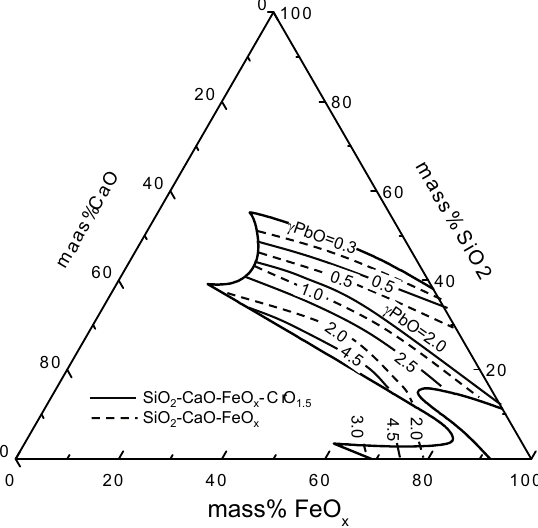
Figure 8. Contours of constant PbO activity coefficient in the slag in equilibrium with metallic iron at 1573